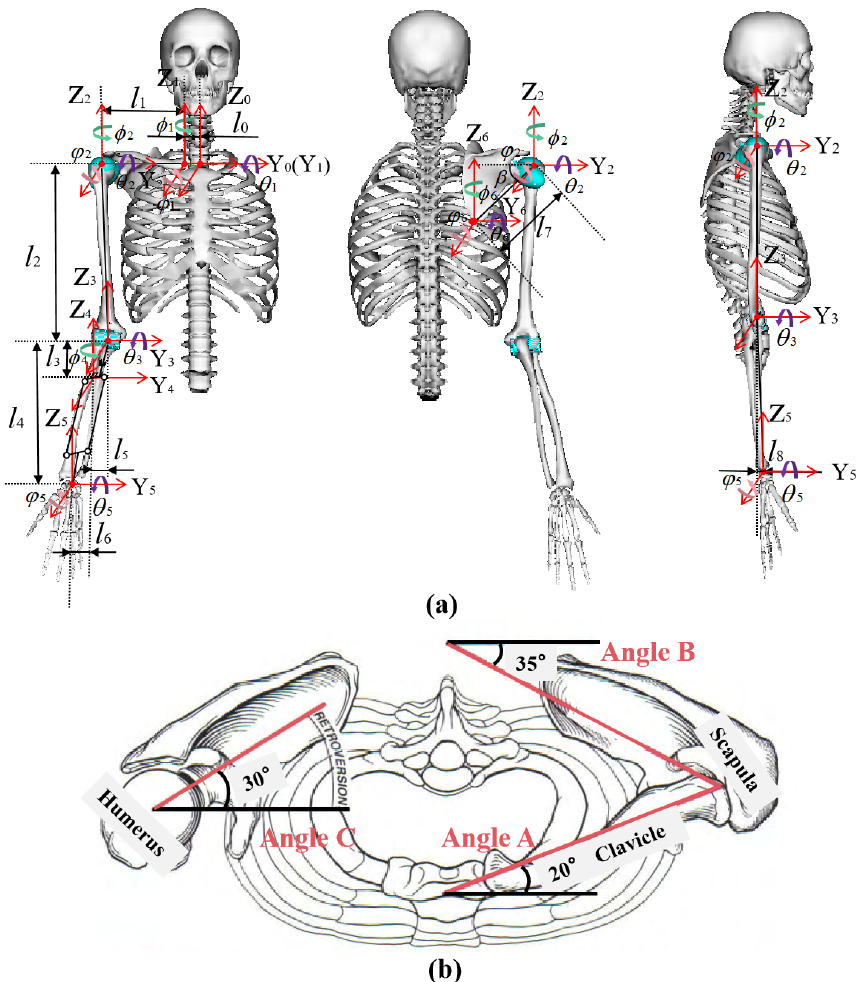
Figure 6. Set the parameters of the model. (a) Front view, back view, and right side view of a human arm. (b) Top view of both shoulders in the anatomical position. Angle A shows that the direction of the clavicle is about 20 ◦ behind the front plane. Angle B shows that the cap is offset by approximately 35 ◦ in front of the front plane. Angle C shows that the humeral head is tilted back about 30 ◦ (Neumann, 2013).